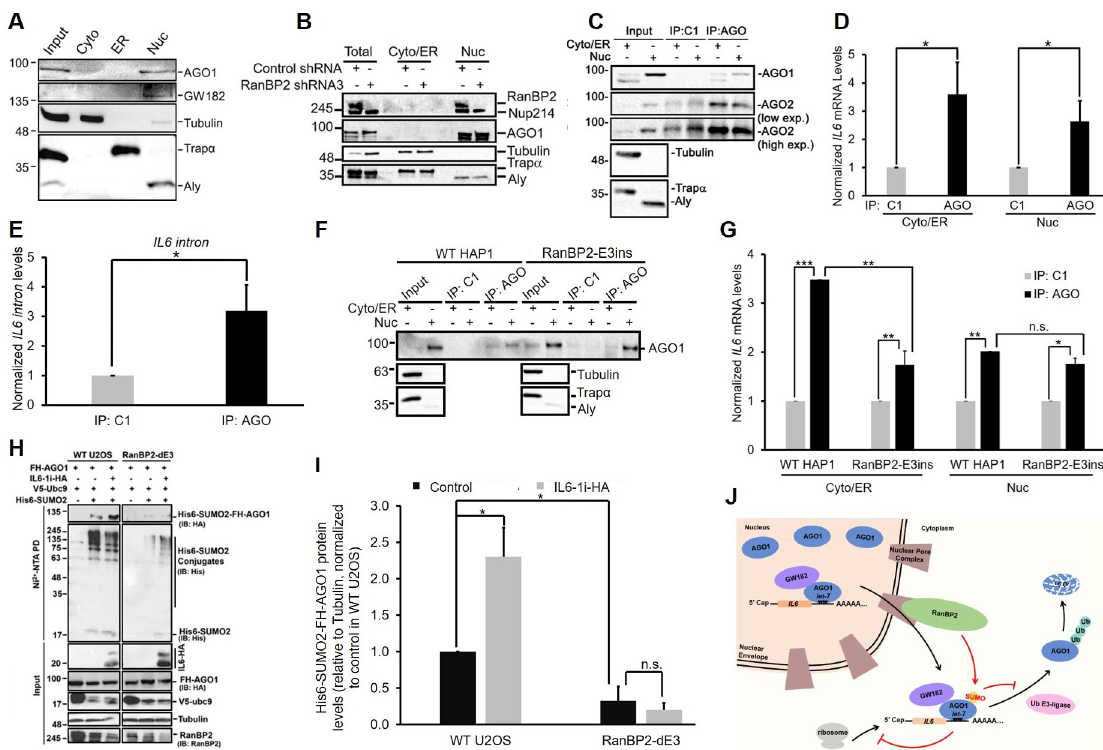
Fig 9. Nuclear Argonautes interact with IL6 mRNA, and require RanBP2-dependent sumoylation to maintain their association with mRNA in the cytosol. (A) U2OS cells were either directly lysed in RIPA buffer (“Input”) or fractionated into cytoplasmic (“Cyto”), ER and nuclear (“Nuc”) fractions. Samples were separated by SDS-PAGE and immunoblotted for AGO1, GW182, α -tubulin (cytosolic marker), Trap α (ER marker) and Aly (nuclear marker). (B) Similar to (A), except that U2OS cells were infected with lentivirus that delivered shRNA3 against RanBP2 for four days, and were then fractionated into cytoplasmic/ER and nuclear fractions. Samples were analyzed by immunoblotting with antibodies against mAb414 (RanBP2 and Nup214), AGO1, α -tubulin (cytosolic marker), Trap α (ER marker) and Aly (nuclear marker). (C-D) U2OS cells were transfected with intronless IL6-HA construct ( IL6- Δ i-HA ). 24 h post-transfection, cells were fractionated into cytoplasmic/ER and nuclear fractions. Fractions were either collected (“Input”) or immunoprecipitated with control (C1) or anti-AGO synthetic antibody fragment. Samples were separated by SDS-PAGE and immunoblotted for AGO1, AGO2 (shown in both low and high exposure), α -tubulin, Trap α and Aly (C). The amount of IL6 mRNA in the immunoprecipitates was quantified by RT-qPCR, each bar representing the average of four independent experiments ± SEM (D). (E) U2OS cells were transfected with an intron-containing IL6-HA construct ( IL6-1i-HA ). 24 h after transfection, cells were lysed and immunoprecipitated with control (C1) or anti-AGO synthetic antibody fragment. The amount of IL6 intron in the immunoprecipitates was quantified by RT-qPCR, each bar being the average of five independent experiments ± SEM. (F-G) Similar to (C-D), except for unmodified and RanBP2-E3ins HAP1 cells. Each bar is the average of three independent experiments ± SEM. (H-I) Unmodified and RanBP2-dE3 U2OS cells were co-transfected with plasmids for Flag-HA- tagged AGO1 ( FH-AGO1 ), SV5-tagged Ubc9 ( V5-Ubc9 ), with or without His-tagged SUMO2 ( His6-SUMO2 “+/-”) and an intron- containing IL6-HA construct ( IL6-1i-HA “+/-”). 24 h post-transfection, cells were lysed in 6 M Guanidinium-HCl, and the His6-SUMO2 conjugates were isolated on Nickel beads (“Ni 2+ NTA PD”) or the lysates were directly analyzed (“input”) and separated by SDS-PAGE. Conjugates were analyzed for the presence of FH-AGO1 by immunoblotting for HA (IB: HA), and for total His6-SUMO2 conjugates by immunoblotting for His (IB: His). Input lysates were immunoblotted with antibodies as indicated (H). Isolated His6-SUMO2-FH-AGO1 and α -tubulin levels were quantified using densitometry analysis and the ratio of His6-SUMO2-FH-AGO1/ α -tubulin was normalized to unmodified U2OS cells without IL6-1i-HA. Each bar is the average of two independent experiments ± SEM. (J) General model for how RanBP2 regulates the silencing of the IL6 mRNA through the sumoylation of AGO1. � P = 0.01–0.05, �� P = 0.001–0.01, ��� P < 0.001, n.s. indicates no significant difference (Student’s t